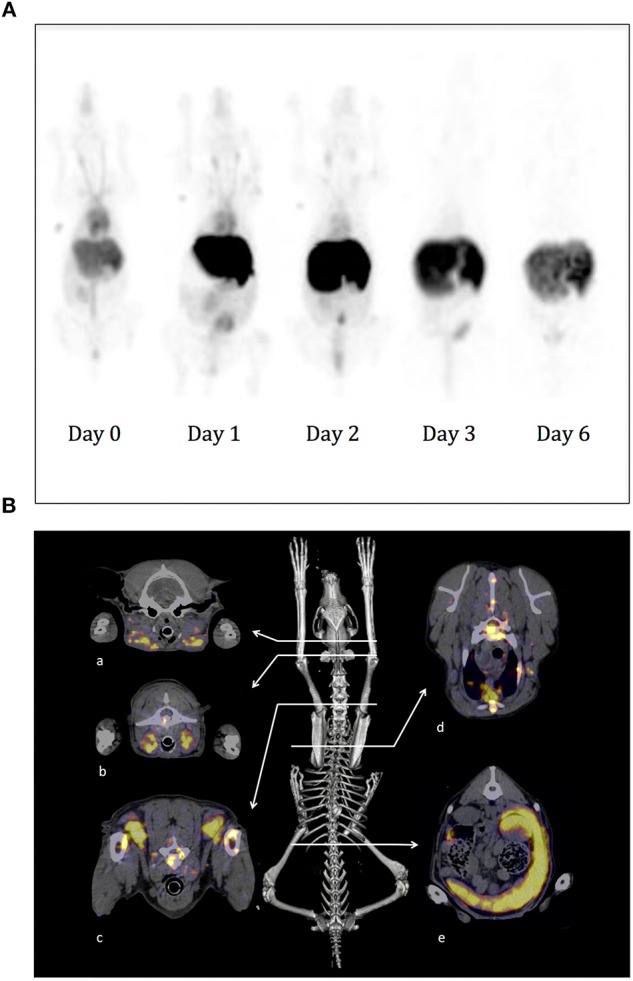
SPECT-CT imaging using 111In-10C6 MAb on experimental and sick dogs. (A) A healthy beagle weighing 11.5 kg was injected under anesthesia with 111In-10C6 at a total activity of 3.7 MBq/Kg and a co-injection of 1.5 mg/kg of cold 10C6. Images were acquired 1 h after injection and then at day 1, 2, 3, and 6. Here are shown a planar projection of the whole-body SPECT images. The nose of the dog and the liver, which are highly vascularized in dogs, appear with a strong contrast. The vasculature is visible up to day 2. The signal in the abdomen corresponds to the elimination of radioactivity in the feces after clearance of 111In-10C6 by the hepatobiliary system. In the first three images, 1 ml of blood taken at the beginning of acquisition positioned close to the anterior left leg was imaged in order to obtain a reference of blood activity. (B) SPECT-CT images of a dog with spontaneous DLBCL diagnosed at the veterinary hospital. The dog was a 4-year-old female Flat-coated Retriever with stage V multicentric lymphoma. SPECT-CT acquisition was performed 45 h after radiopharmaceutical injection (0.75 mg 111In-10C6; specific activity 113.9 MBq.mg−1; without co-injection of cold 10C6). The skeleton is shown as the anatomic landmark. Here are shown the fusion SPECT and CT images where tumor sites could be easily visualized. a: Mandibular lymph nodes; b: retropharyngeal lymph nodes; c: prescapular lymph nodes; d: body of a thoracic vertebra, substernal lymph node; e: spleen.